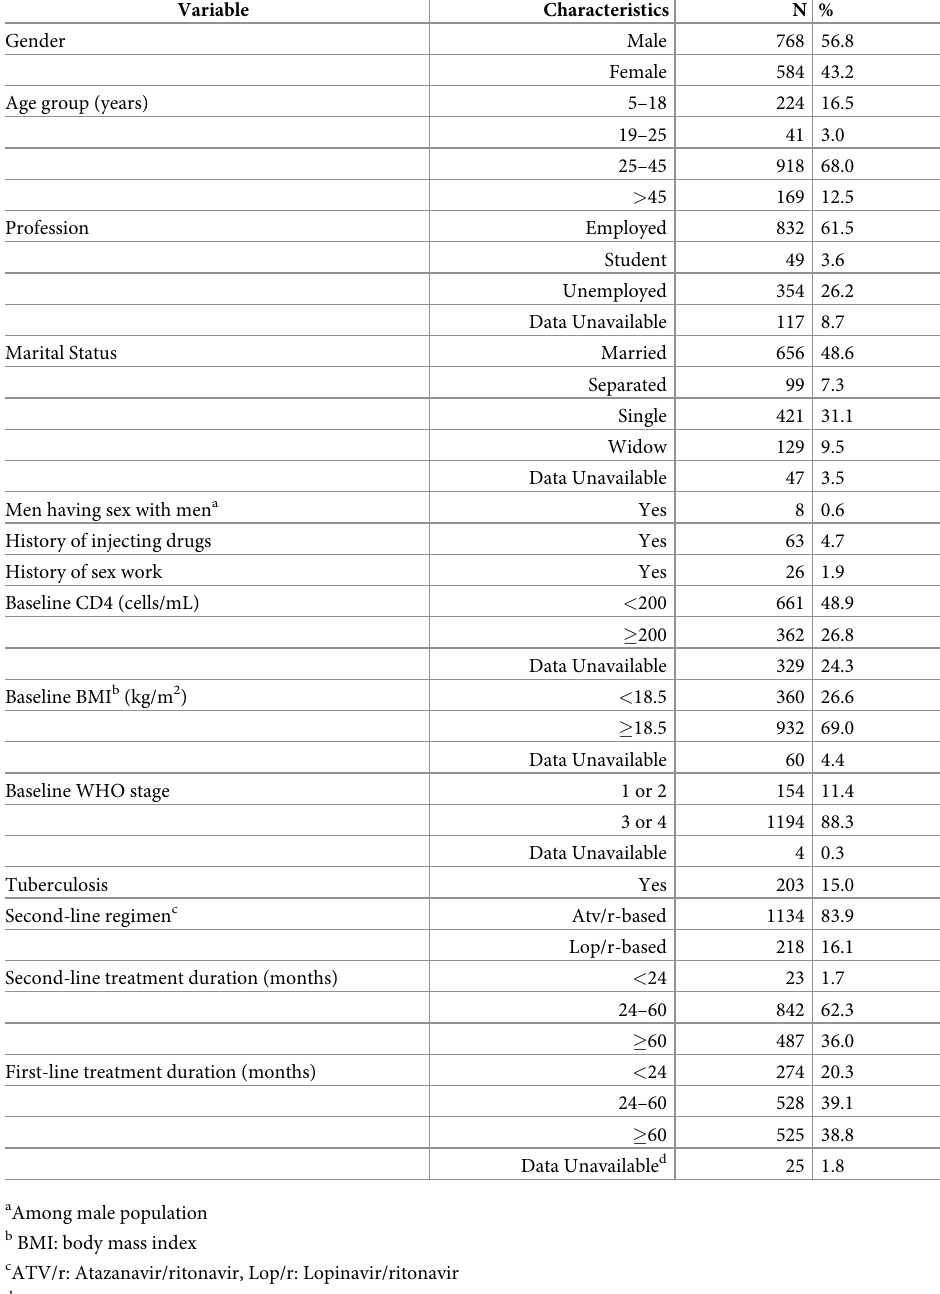
Table 1. Demographic and clinical characteristics of the study population at the time of second-line treatment initiation (N =